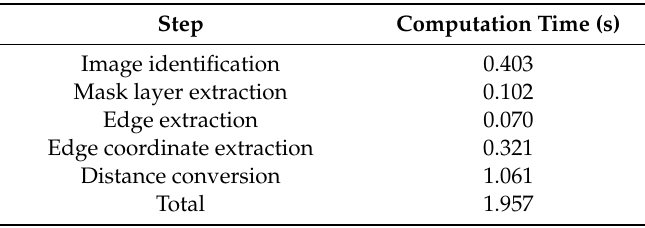
Table 4. Time for each step in the proposed